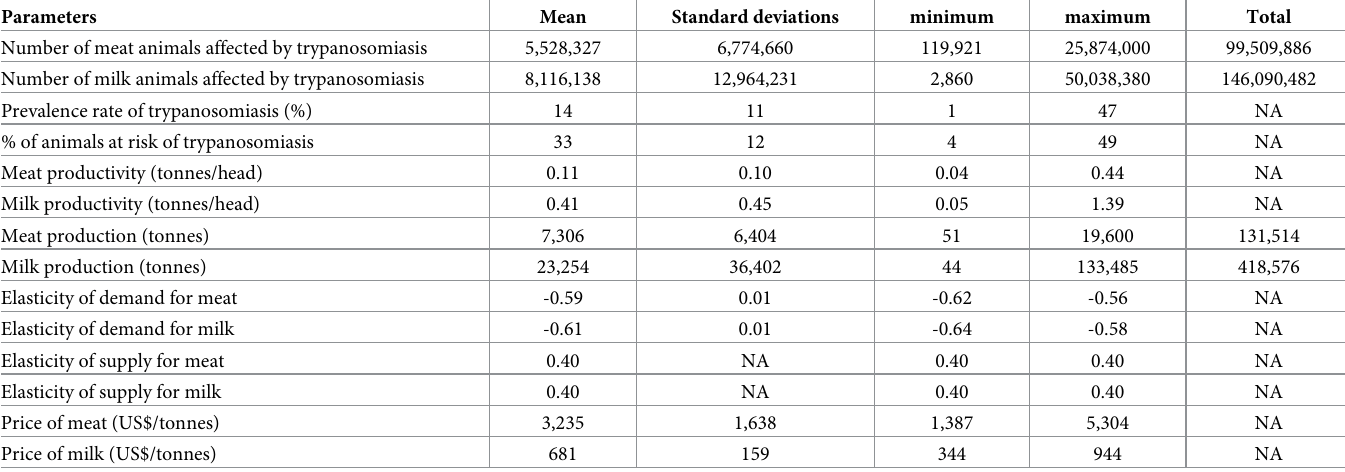
Table 1. Parameters of the economic surplus